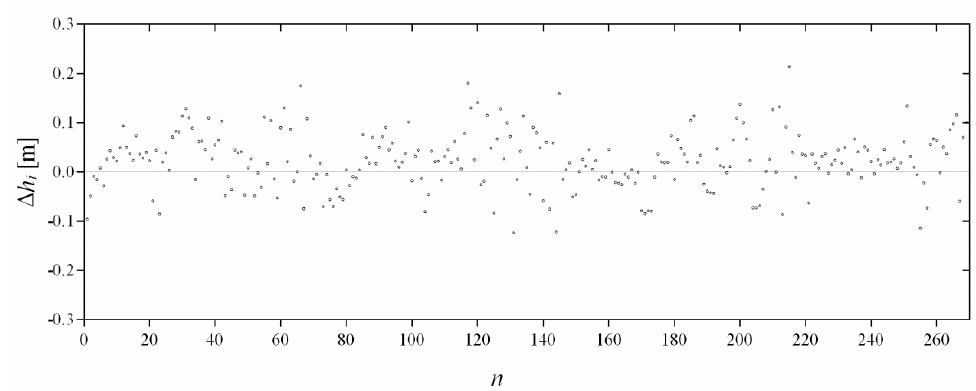
Figure 18. Presentation of height differences of apex points in real urban testing pools.